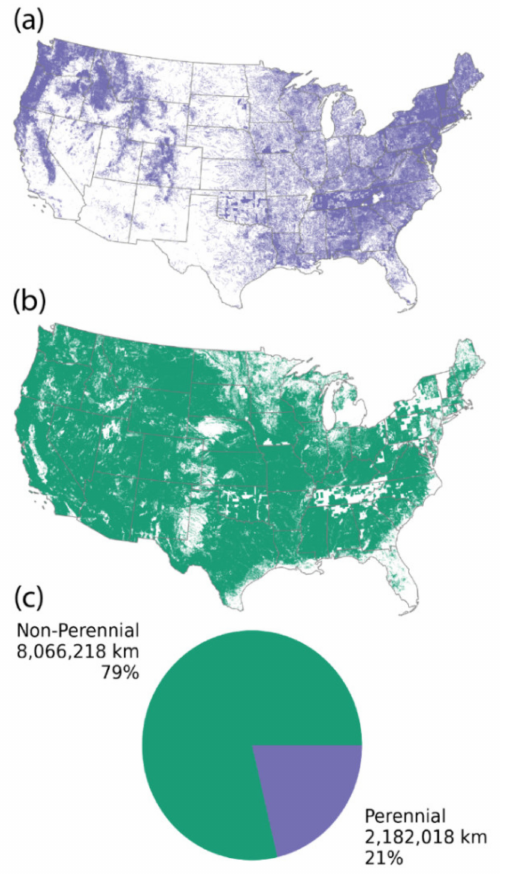
Figure 1. Maps showing the distribution of perennial ( a ) and non-perennial ( b ) streams in the Continuous United States (CONUS) from the U.S. Geological Survey National Hydrography Dataset (NHD) High-Resolution Hydrography [32] and the total and relative lengths of each category ( c ). The National Water Information System, (NWIS, waterdata.usgs.gov accessed on 15 February 2021) is a high-quality, consistent database that reports discharge from the